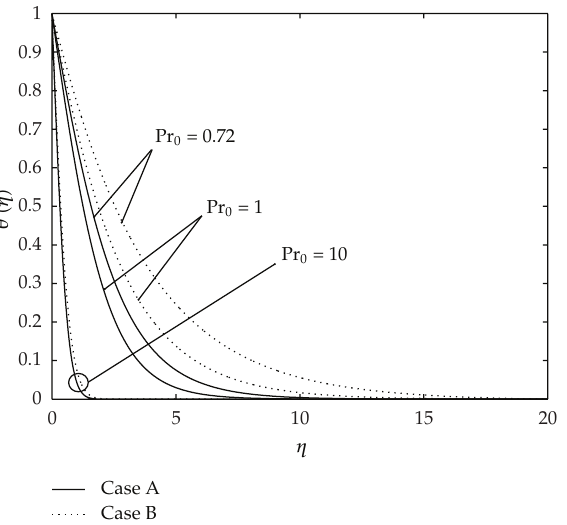
Figure 4: Dimensionless temperature profiles θ (cid:5) η (cid:6) for di ff erent values of Pr 0 when ε (cid:8) 0 and a (cid:8) 1. Case A (cid:5) solid line (cid:6) : constant viscosity and Case B (cid:5) dotted line (cid:6) : inversely linear viscosity, (cid:5) 3.5 (cid:6) , and (cid:5) 3.6 (cid:6)